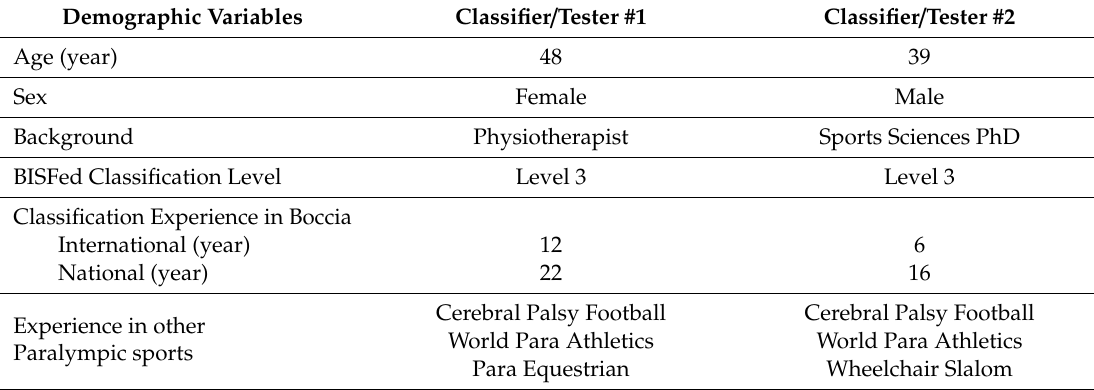
Figure 2. Participants set up on the stable surface (left). Screen feedback with the red dot representing the target and its trajectory and the yellow dot representing participants’ center of pressure (right).